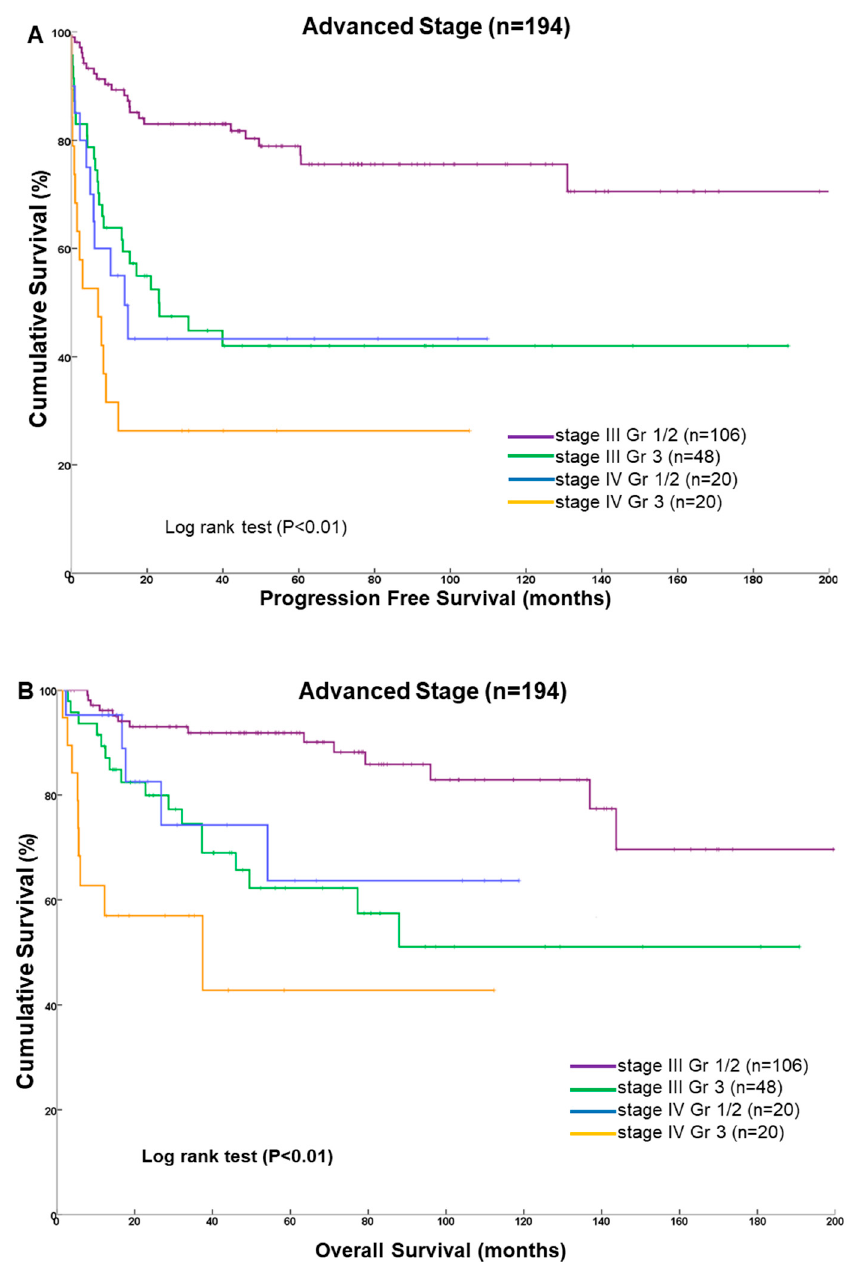
Figure 3. Kaplan–Meier estimates of survival for 194 patients with advanced-stage endometrioid endometrial carcinoma. ( A ) Progression-free survival; ( B ) overall survival. Four distinct subgroups represent different disease stages and tumor grades.